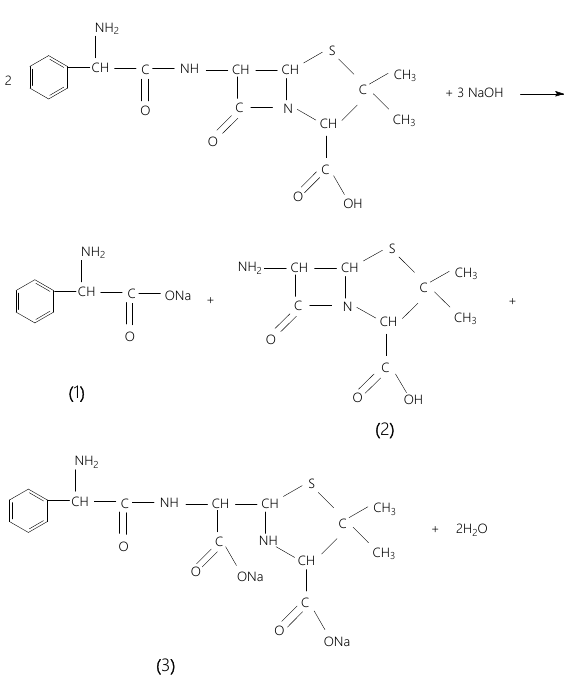
Figure 10. Raman spectra of AM ( a ) and NaOH-reacted AM ( b ). The insert of ( a , b ) shows the Raman spectra after the baseline correction.